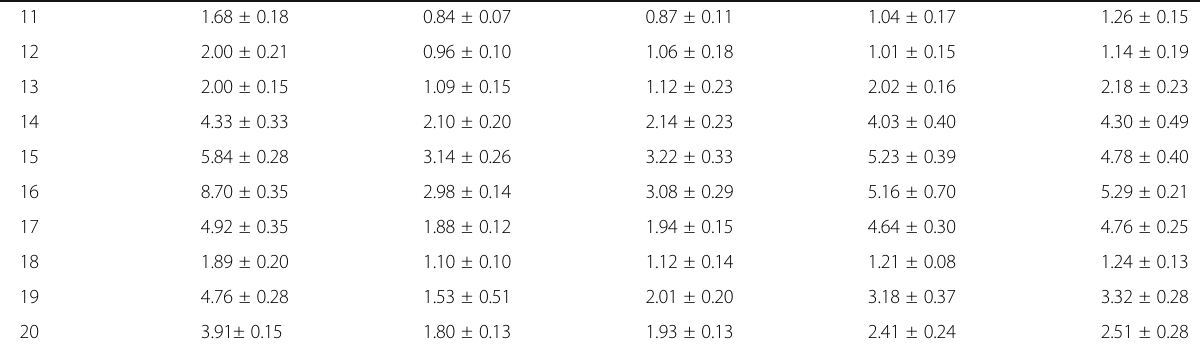
Table 3 Precision of two different splints (MaxS and VestS) measured at twenty bone marker points. Group A was measured immediately after completion. Group B was reattached ten times and measured. Accuracy (Mean ± SD) as difference between position of the targets in the CT and the targets position using a navigation system (Continued)